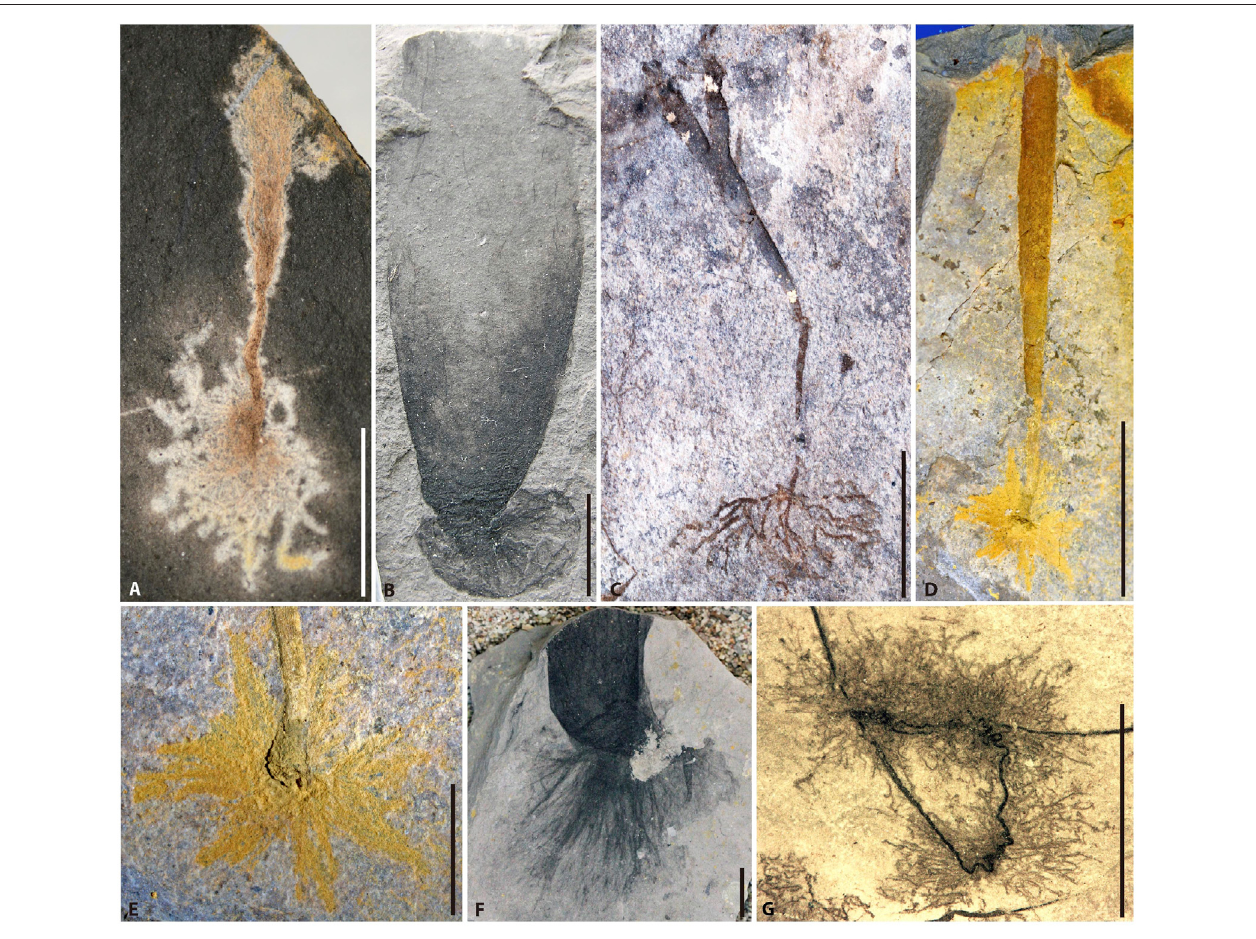
FIGURE5| MacroalgaeandtheirholdfastsfromtheMiaohebiota. (A) Longifuniculumdissolutum witharhizoidalholdfast,PB23771. (B) Gesinellahunanensis with a discodial holdfast, MH-40-245B. (C) Konglingiphyton erecta , PB23773. (D) Baculiphyca taeniata , PB23772. (E) Enlargement of the rhizoidal holdfast in (D) . (F) Gesinella hunanensis with rhizoids, MH-57-1058B. (G) Globusphyton lineare with horizontal rhizomes, MH-40-0248. Scale bars represent 10 mm.